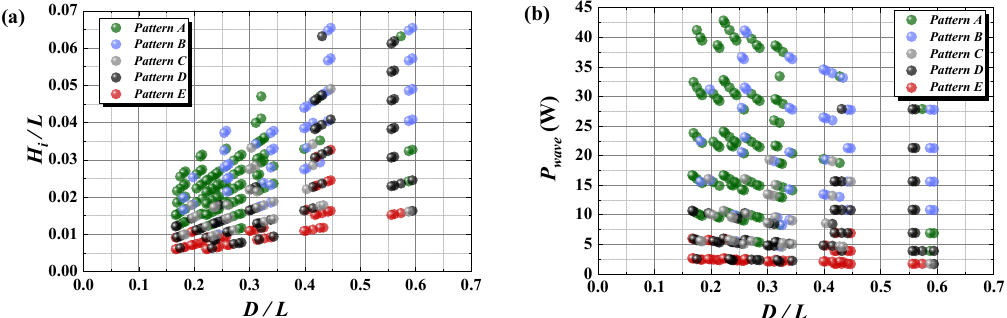
Figure 8. Tendency for the respective patterns depending on ( a ) D / L and H i / L , and ( b ) D / L and P wave .